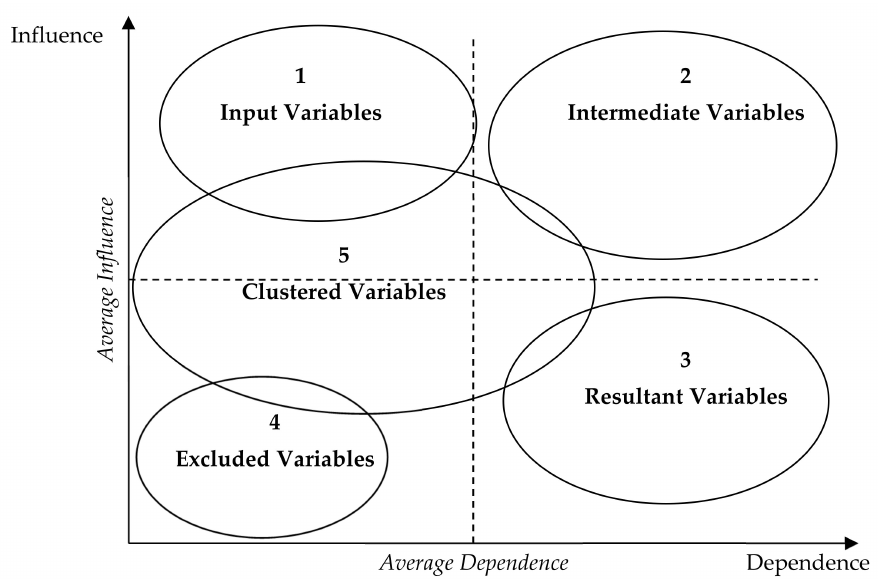
Figure 8. Different types of variables on the influence and dependence matrix. Source: Own research. Graphical presentation of the map of the indirect influence of factors determining the development of the BSS together with the classification is shown in Figure